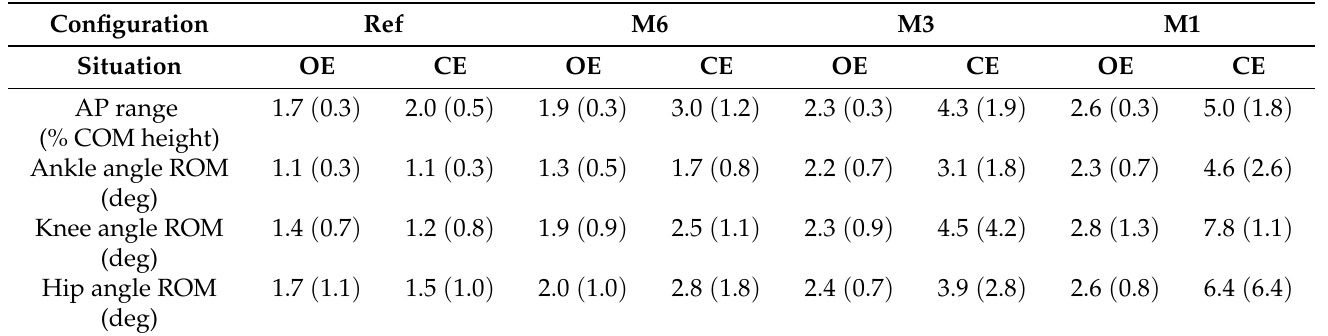
Table 3. Mean (sd) of the COP AP range normalized by the COM height (AP range) and the joint angles ROM for each configuration and